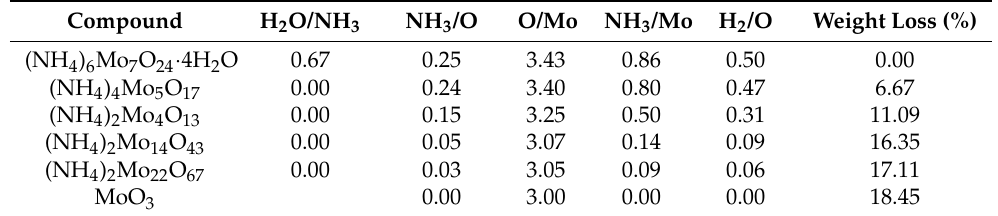
Table 1. Weight and composition changes in ammonium molybdates in stepwise thermal decomposition.